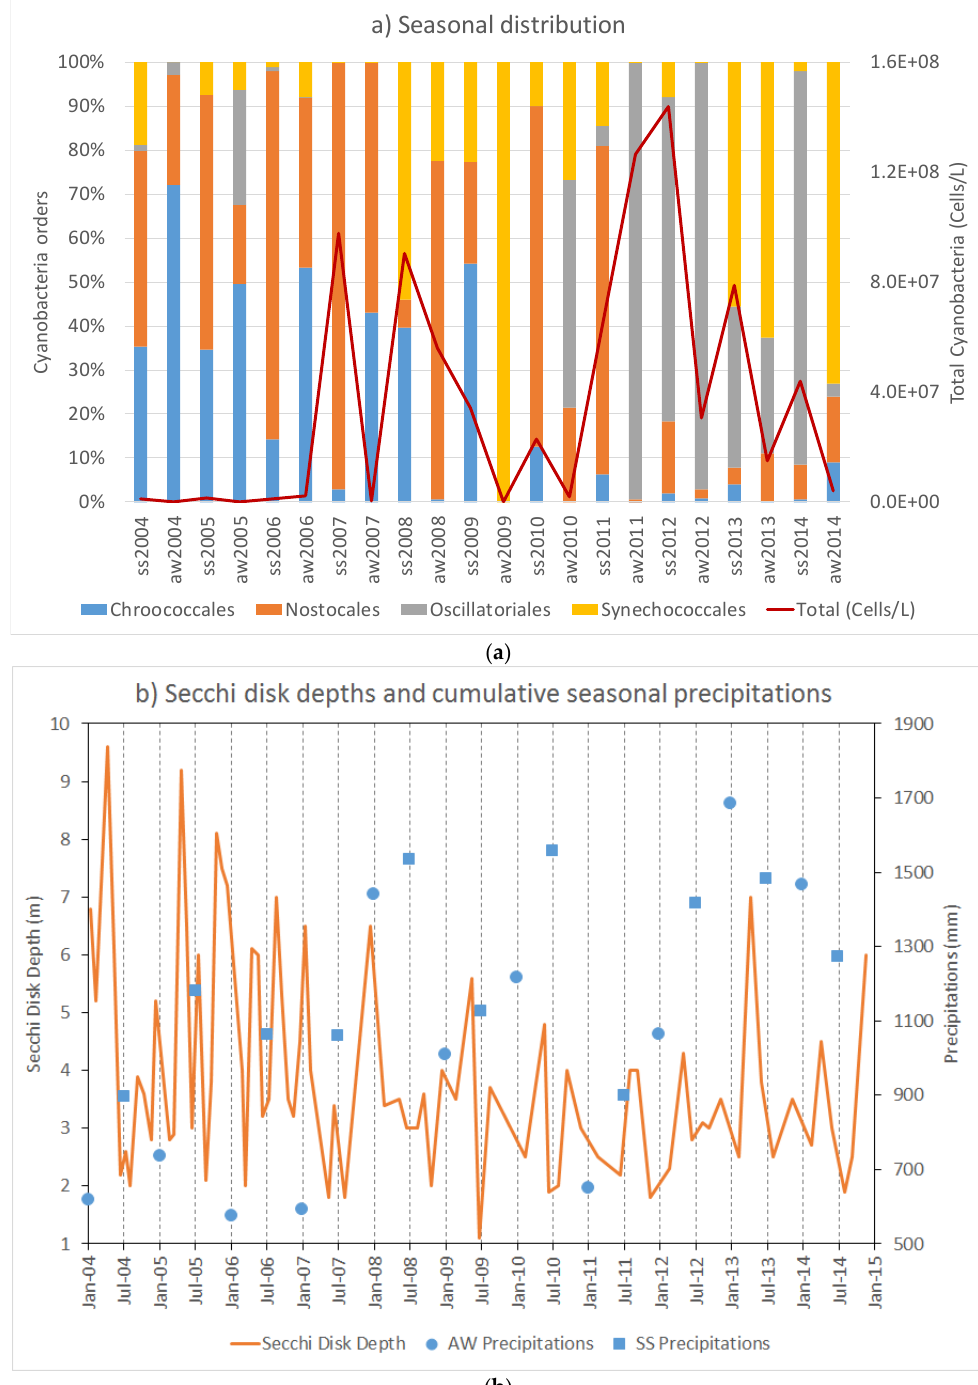
Figure 3. ( a ) The top graph shows a representation of total cyanobacteria community distribution as percentage, based on biovolume (mm 3 /m 3 ). Community distribution is presented as the average of the annual campaigns data, grouped as Summer-Spring (ss) and Autumn-Winter (aw) seasons, and by order. The red line reports the total cyanobacteria number per data set; ( b ) bottom graph represents the Secchi disk depth (continuous line in orange) at each sampling campaign and the six-month cumulative precipitations, Autumn-Winter (aw, blue circles) and Spring-Summer (ss, blue squares).